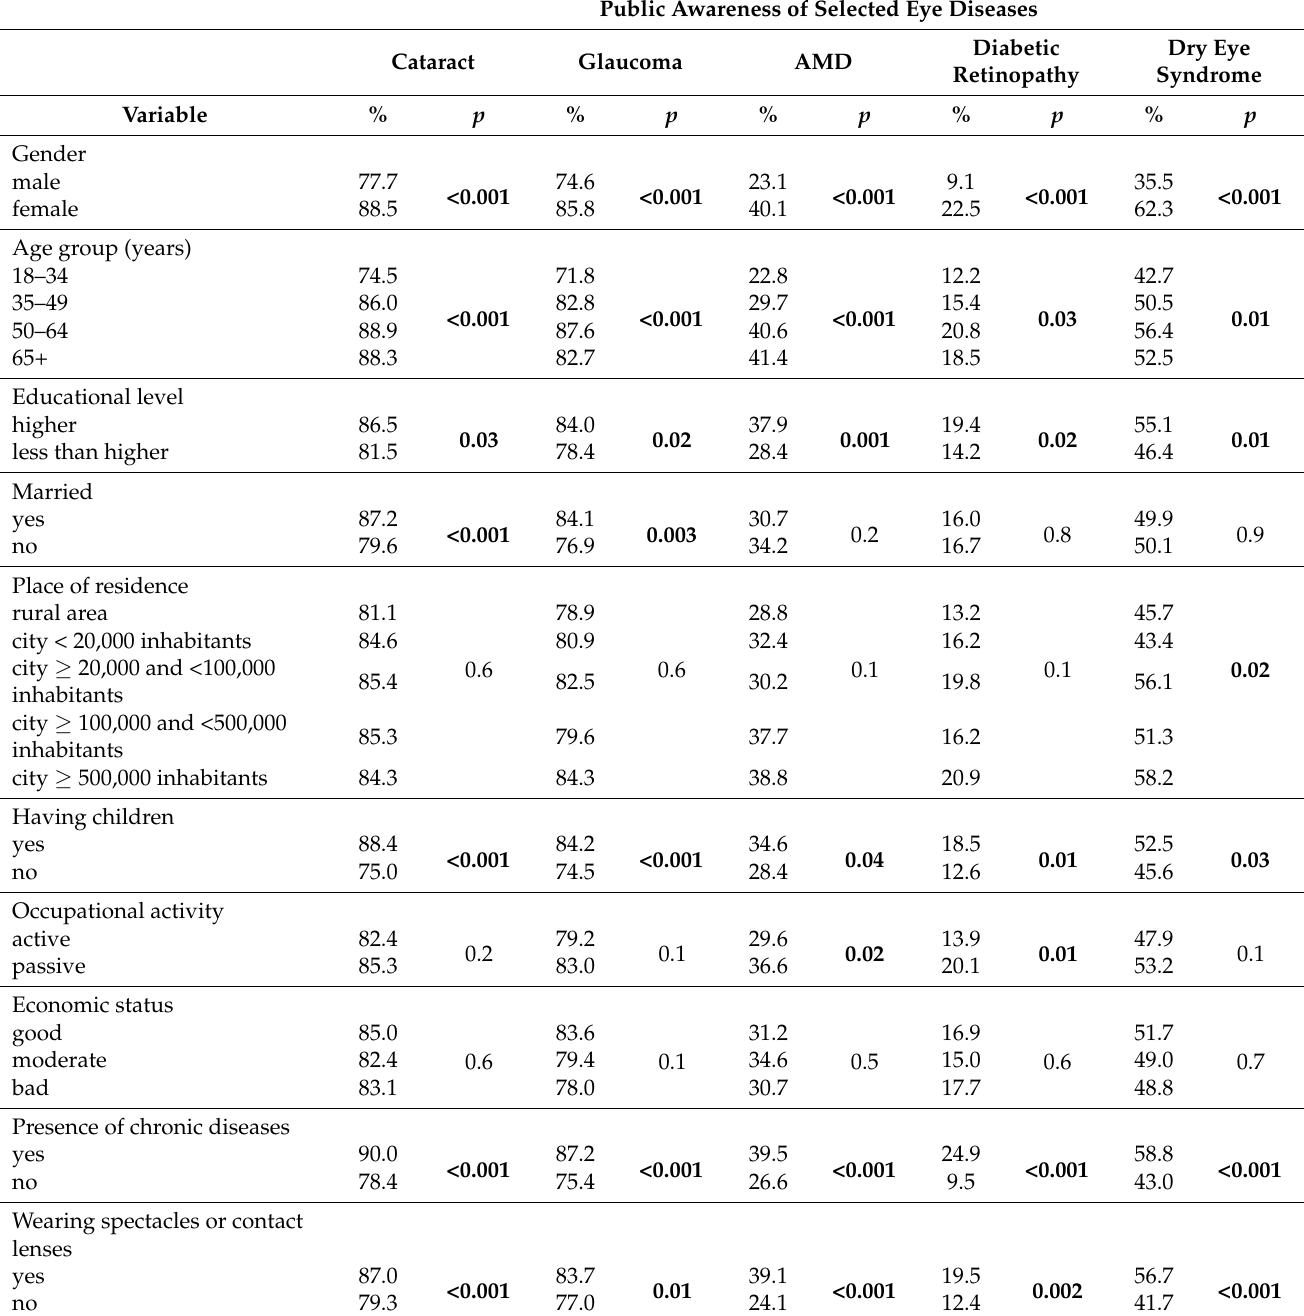
Table 3. Public awareness of selected eye diseases by sociodemographic factors (n = 1076). Public Awareness of Selected Eye Diseases Cataract Glaucoma AMD